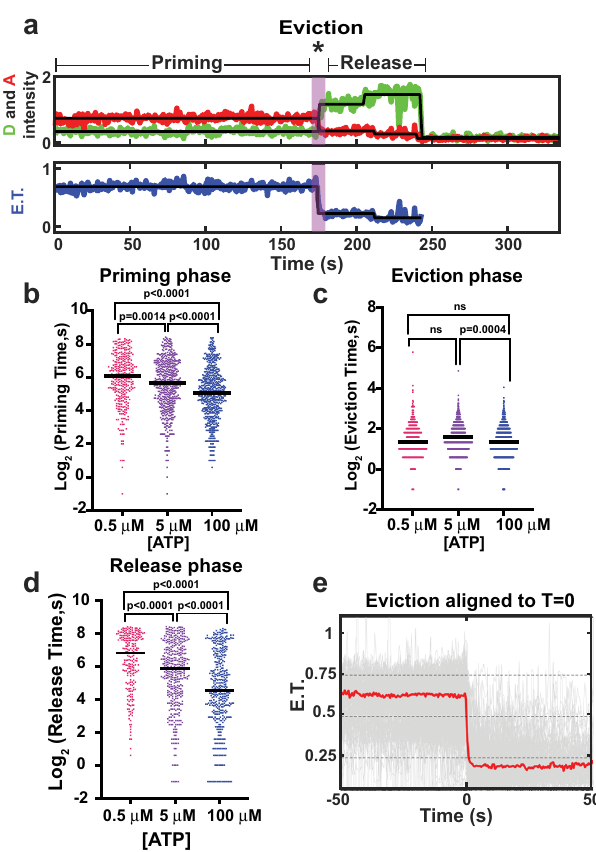
Fig. 3 | The duration of the priming and release phase is dependent on ATP concentration. a Example trajectory highlighting priming, eviction, and release intervals. The Cy3B donor fl uorophore was excited, and donor emission (green) and ATTO 647N acceptor emission (red) were recorded (top panel) and used to calculateenergytransferef fi ciency(blue,bottompanel).The*indicatesevictionof H2A. b Distribution of the priming phase duration for the indicated ATP con- centration, 100 μ M ATP N =635 observed events for 939 nucleosomes from 8 replicates, 5 μ M ATP N =567 observed events for 940 nucleosomes from 8 repli- cates, 0.5 μ M ATP N =325 observed events for 865 nucleosomes from 7 replicates. c Distribution of the eviction phase duration for the indicated ATP concentration, 100 μ M ATP N =635 observed events for 939 nucleosomes from 8 replicates, 5 μ M ATP N =567 observed events for 940 nucleosomes from 8 replicates, 0.5 μ M ATP N =325 observed events for 865 nucleosomes from 7 replicates. e Distribution of the release phase duration for the indicated ATP concentration, 100 μ M ATP N =431 observed events for 939 nucleosomes from 8 replicates, 5 μ M ATP N =396 observed events for 940 nucleosomes from 8 replicates, 0.5 μ M ATP N =227 observed events for 865 nucleosomes from 7 replicates. In b – d black line is the median, c ns,notsigni fi cant,forone-wayANOVATukey ’ smultiplecomparisontest. e Alignment of E.T. trajectories with eviction phase centered at zero with 100 μ M ATP ( N =635 observed events for 939 nucleosomes from 8 replicates), red line is the median. Source data for ( b ) and ( d ) are provided with this